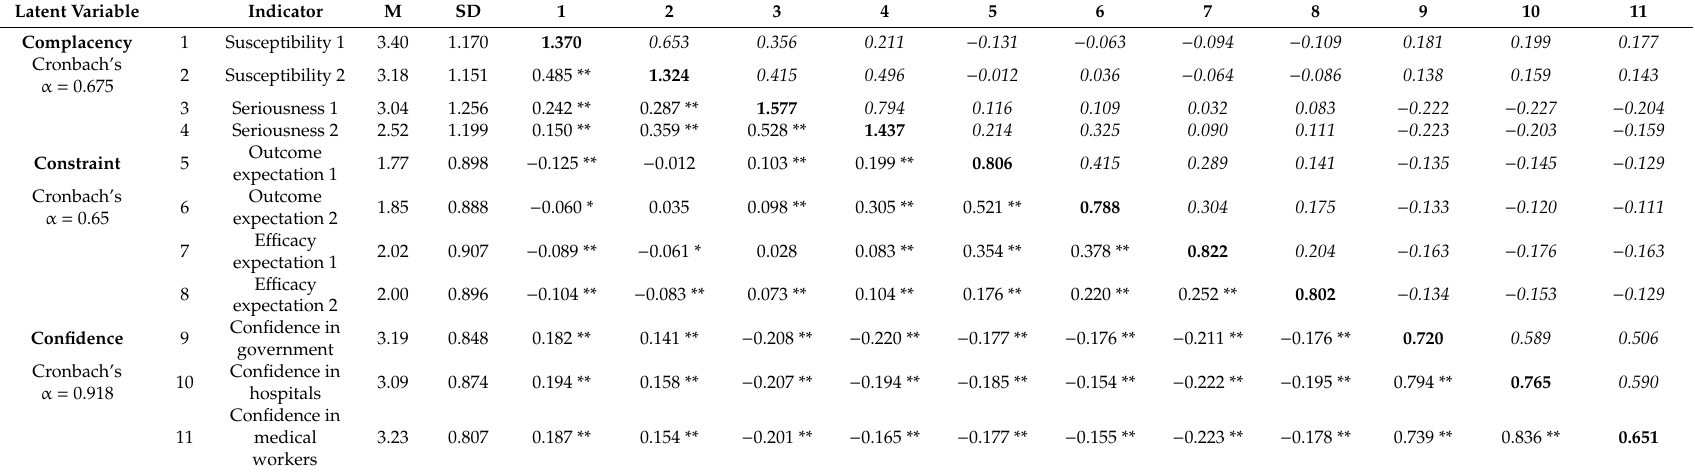
Table 4. variance, covariance, and correlations of indicators, Cronbach’s α for constructed latent variable